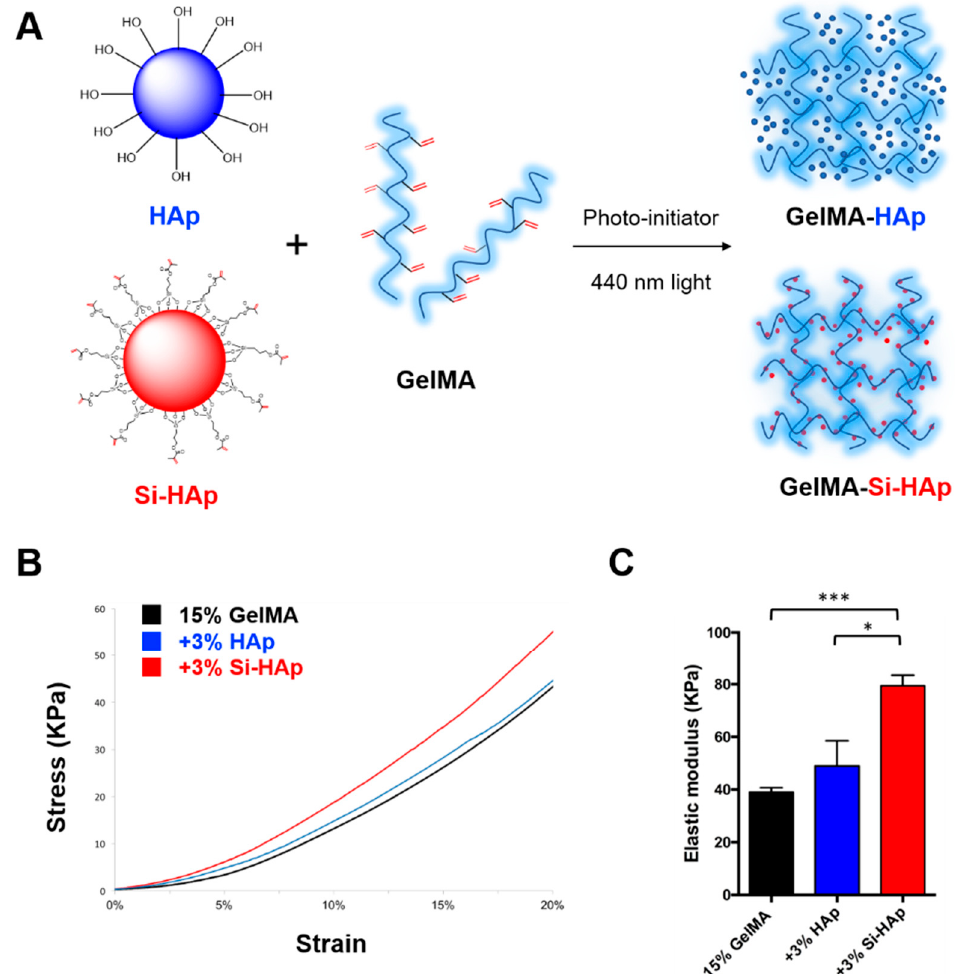
Figure 3. Mechanical properties of cell-free GelMA-HAp and GelMA-Si-HAp composite hydrogels. ( A ) Schematic representation of the preparation of composite hydrogel constructs. ( B ) Stress and strain curve of GelMA-HAp (blue) and GelMA-Si-HAp (red) hydrogels (3% fillers). ( C ) Elastic modulus of GelMA-HAp and GelMA-Si-HAp hydrogels. * p < 0.05, *** p < 0.001.